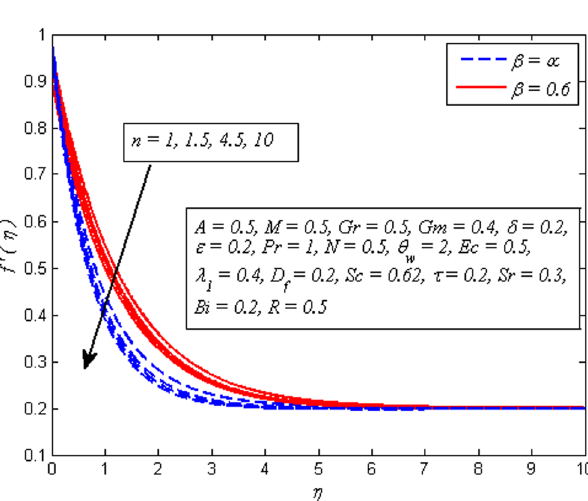
Figure 3. Effect of β on velocity for three different values of A .